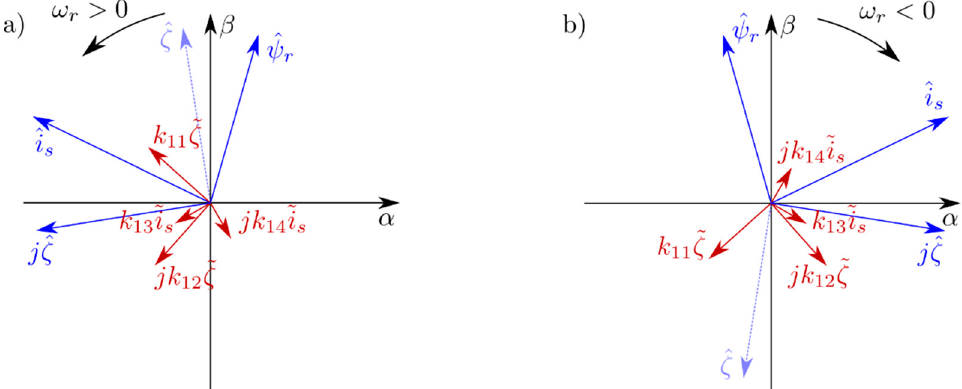
Figure 8. Vectors from the right side of the first equation of the observer for: ( a ) positive speed values (vectors rotating counterclockwise) and ( b ) negative speed values (vectors rotating clockwise).